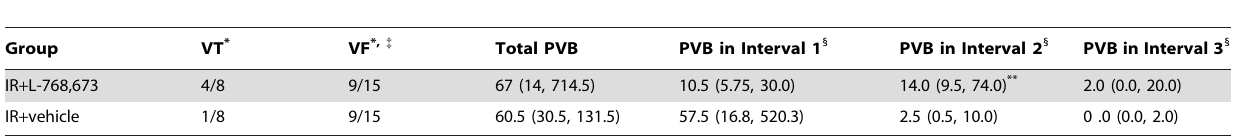
Table 2. Ventricular tachycardia (VT), ventricular fibrillation (VF), and total premature ventricular beats (PVB) of the ischemia/ reperfusion (IR) + L-768,673 and IR + vehicle groups.